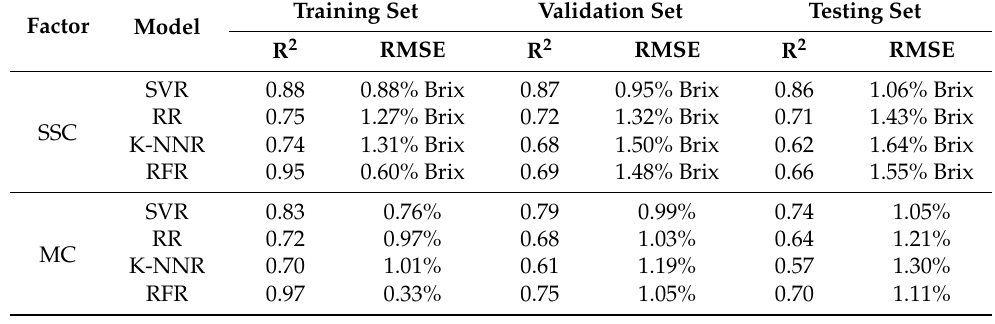
Table 4. The performance for each prediction model.